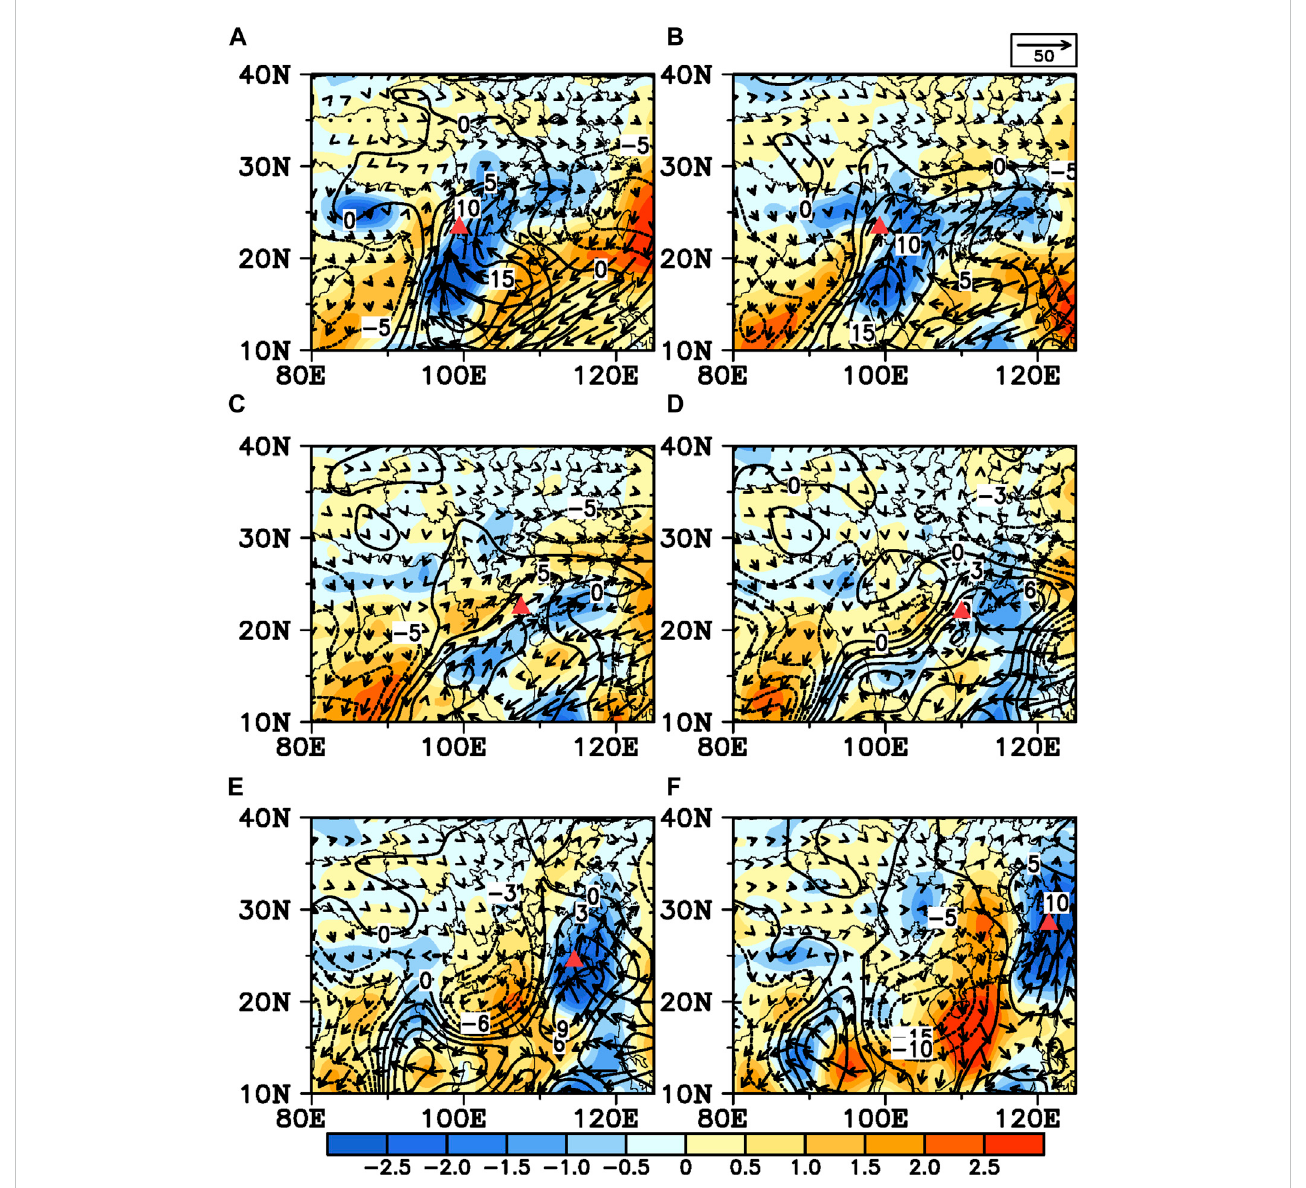
FIGURE 6 Column-integrated water vapor fl ux (vectors; units: kg m − 1 · s − 1 ), the divergence of the column-integrated (surface – 300 hPa) water vapor fl ux (shading; units:10 – 5 kg · m − 2 · s − 1 )andtheprecipitablewateranomalies(contours;units:mm)onJanuary (A) 8, (B) 9, (C) 10, (D) 11, (E) 12and (F) 13in2015.Theredtriangle indicates the large-value center of